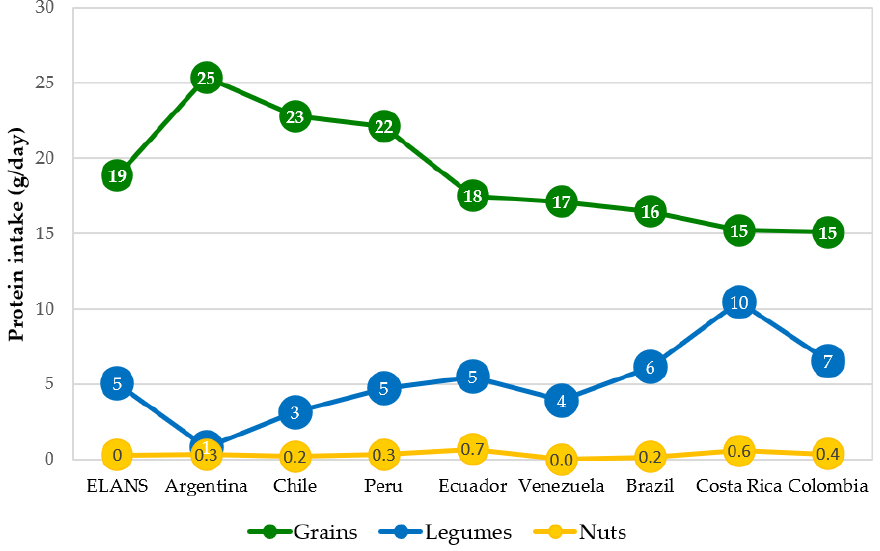
8 of 15 . Figure 5. Mean daily animal protein intake (g/day) by food group and ELANS countries.